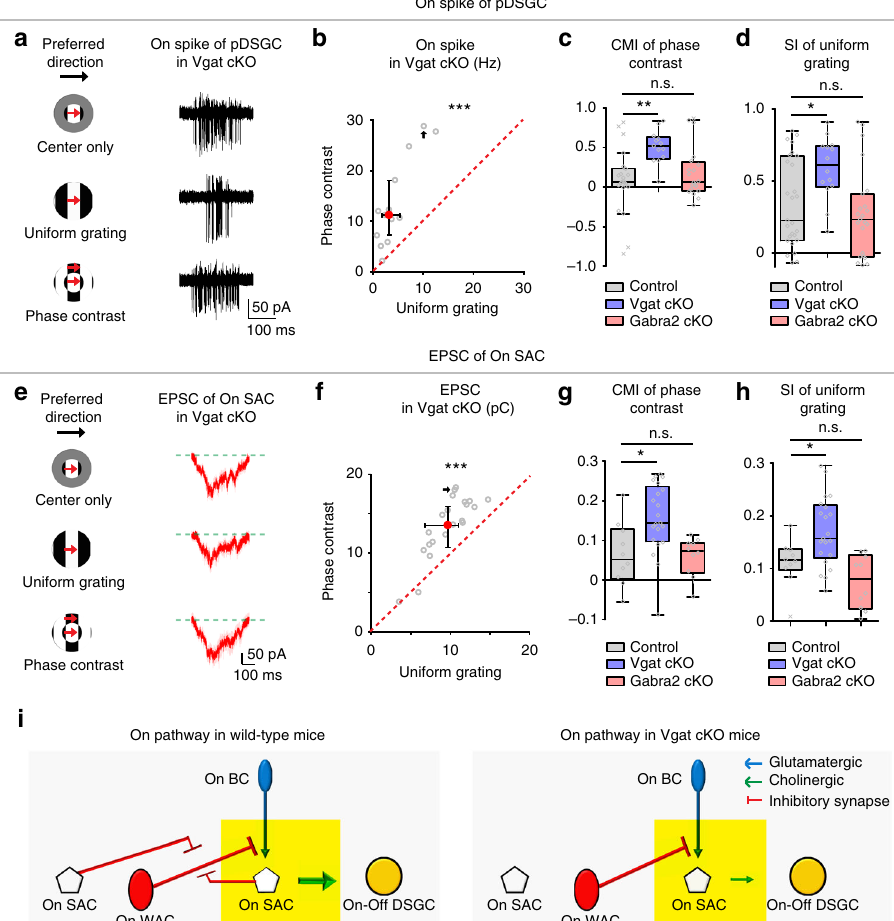
Fig. 6 Conditionally knocking out Vgat in SACs unmasks strong contextual modulation in the pDSGC On pathway. a Example On spike traces of a pDSGC in Vgat cKO mouse. b Scatter plot compares pDSGC On fi ring rate during uniform grating and phase-contrast grating in Vgat cKO mice: n = 13 cells from 7 mice, *** p < 0.001. c Summary graph compares CMI of phase-contrast for pDSGC On response in control, Vgat cKO and Gabra2 cKO mice: Kruskal – Wallis test: ** p = 0.0016. Wilcoxon rank-sum test with Bonferroni correction: Control vs Vgat cKO: ** p = 0.00080; Control vs Gabra2 cKO: p = 0.78. d Summary graph compares SI of pDSGC On fi ring rate during uniform grating between control, Vgat cKO and Gabra2 cKO mice: Kruskal-Wallis test: ** p =